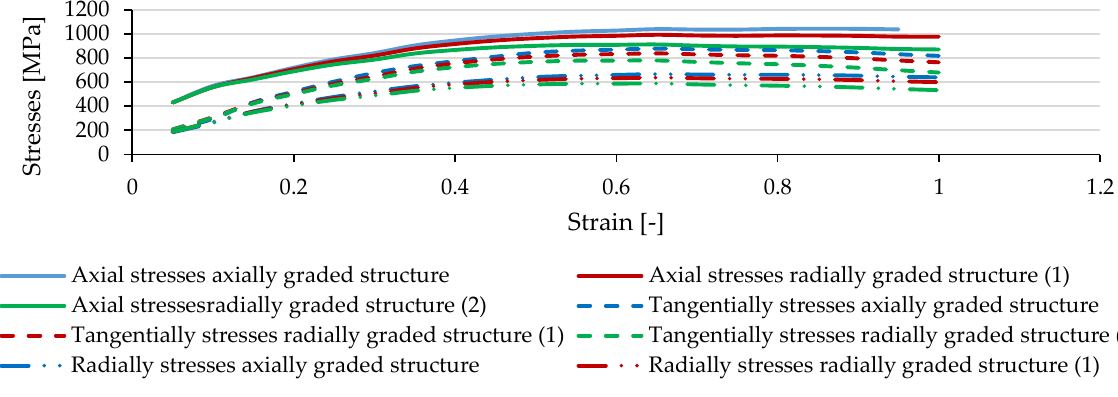
Figure 3. Bulging behavior of the different graded specimen types at the same way of deformation of about 10 mm.